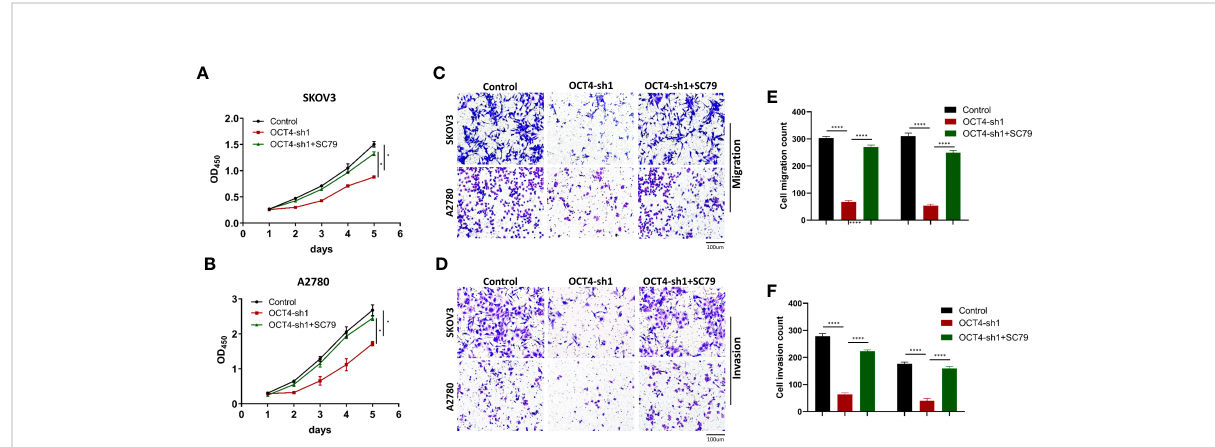
FIGURE 6 OCT4 modulated proliferation, migration and invasion by activating the AKT signaling pathway in OC cells. (A, B) In SKOV3 and A2780 cell lines, CCK-8 assay data showed that SC79 treatment rescued the inhibition of proliferation by OCT4 knockdown. (C – F) Transwell assays indicated that the suppression of migration and invasion ability by OCT4 knockdown was rescued after SC79 treatment. (Data were expressed as the mean ± SD. Signi fi cance was calculated using Student ’ s t-test. *P<0.05, ****P<0.0001.)